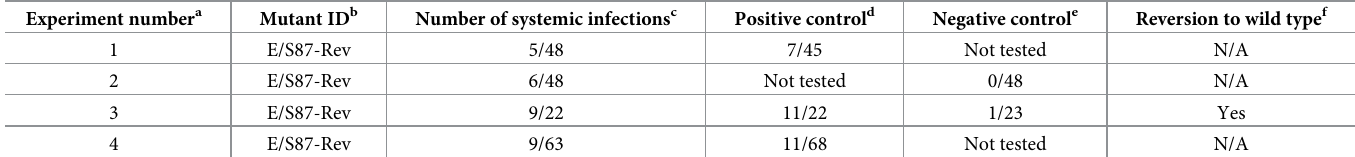
Table 4. Infectivity of a forced-reversion of a FBNSV CP